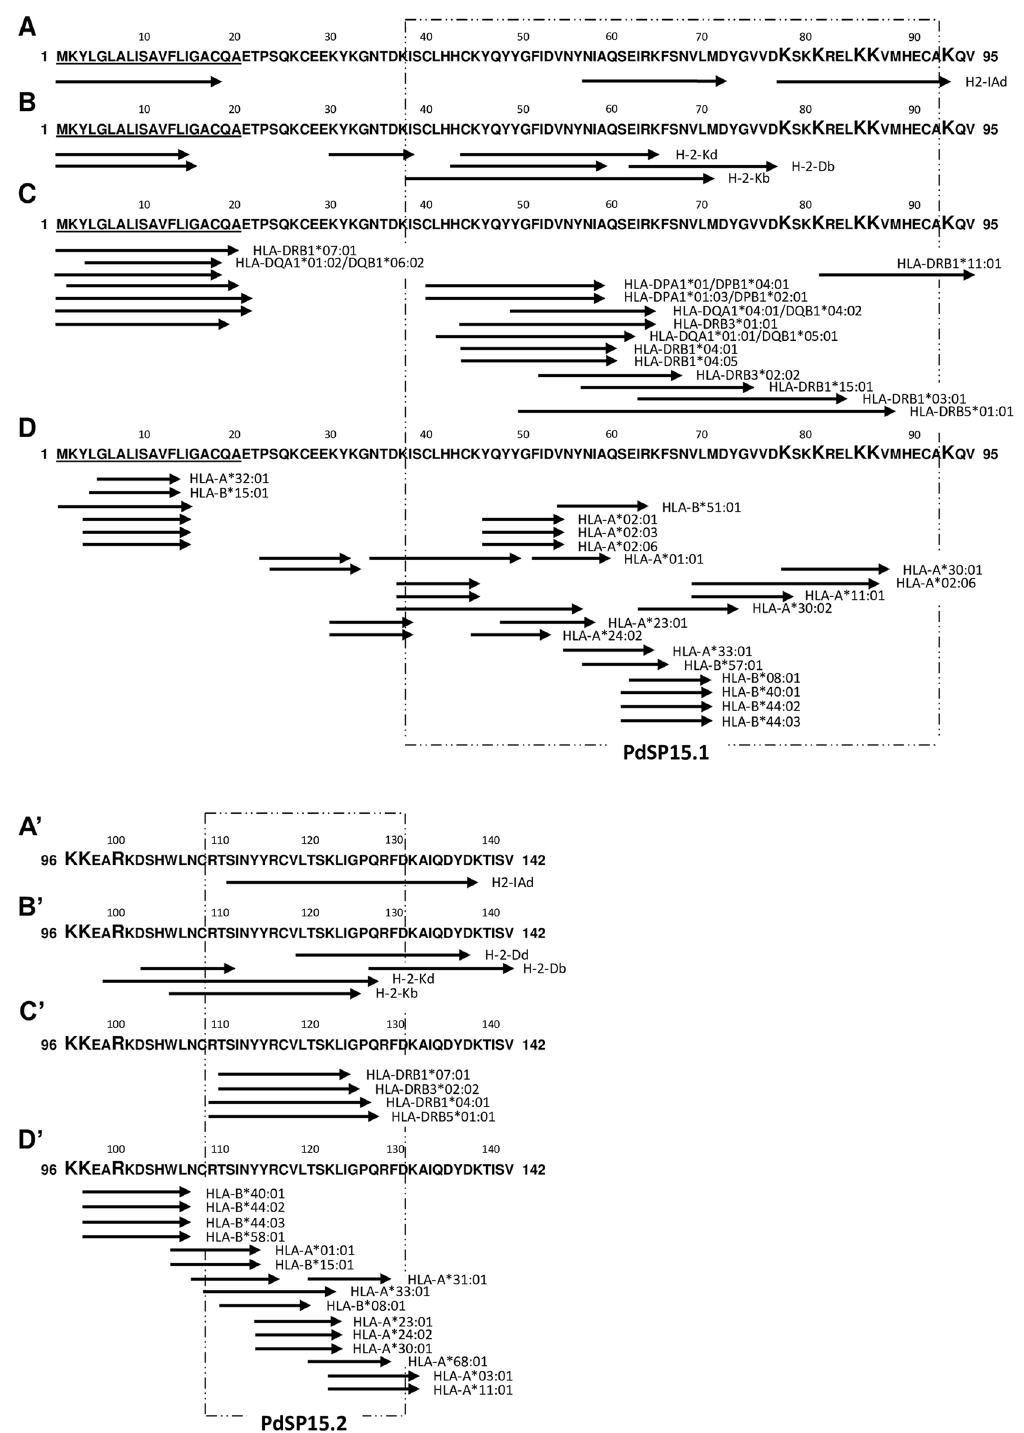
Figure 1. PdSP15 T cell epitope mapping: overall picture of the in silico analysis performed against murine and human MHC-I and MHC-II molecules. PdSP15 (GenBank Acc. No. ABI15933) T cell epitope mapping was performed using the IEDB Analysis Resource considering 3 murine and 27 human MHC-II alleles and 5 murine and 27 human MHC-I alleles. The translated results of the predictions of murine MHC-II restricted epitopes ( A , A ′ ), murine MHC-I restricted epitopes ( B , B ′ ), human MHC-II restricted epitopes ( C , C ′ ) and human MHC-I restricted epitopes ( D , D ′ ) are represented. Results are shown by allele. Each arrow represents one or more (contiguous) predicted epitopes: the top 1% hits for MHC-I molecules and the top 2.5% (very high affinity binders) or 10% hits for MHC-II human and murine alleles, respectively. The underlined protein residues represent the signal peptide sequence. The magnified protein residues are potentially important for protein biological activity. Dashed boxes represent the convergent analysis of the different in silico determinations that enabled the selection of two protein portions to be included in the final chimeric sand fly salivary